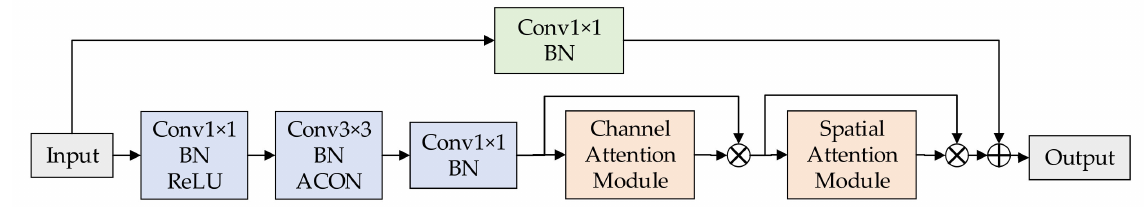
Figure 3. The first three layers of the residual module